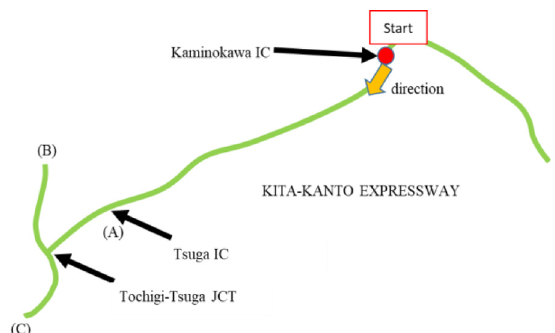
Figure 4 Outline map of the driving